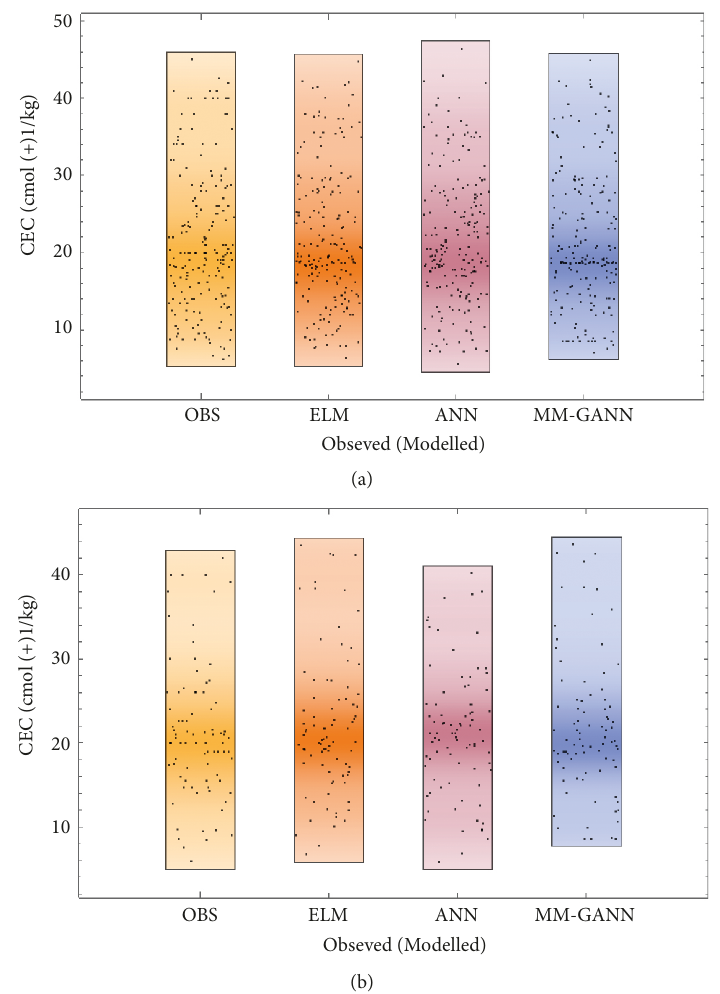
Figure 12: Point density plots of the models at the training (a) and testing (b)